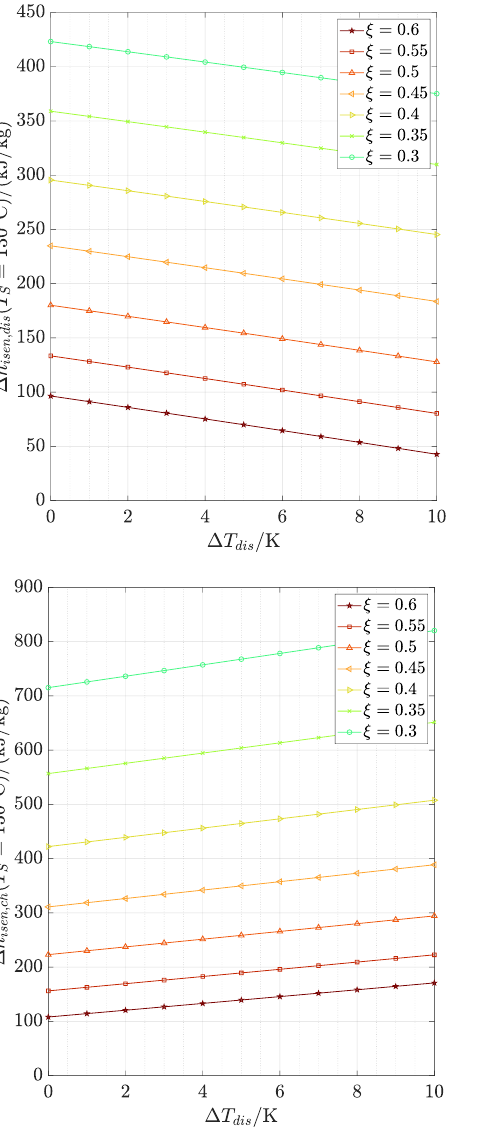
Figure 8. Isentropic enthalpy difference ∆ h isen over working-fluid mass fraction and driving temper- ature difference for discharging ( top ) and charging ( bottom